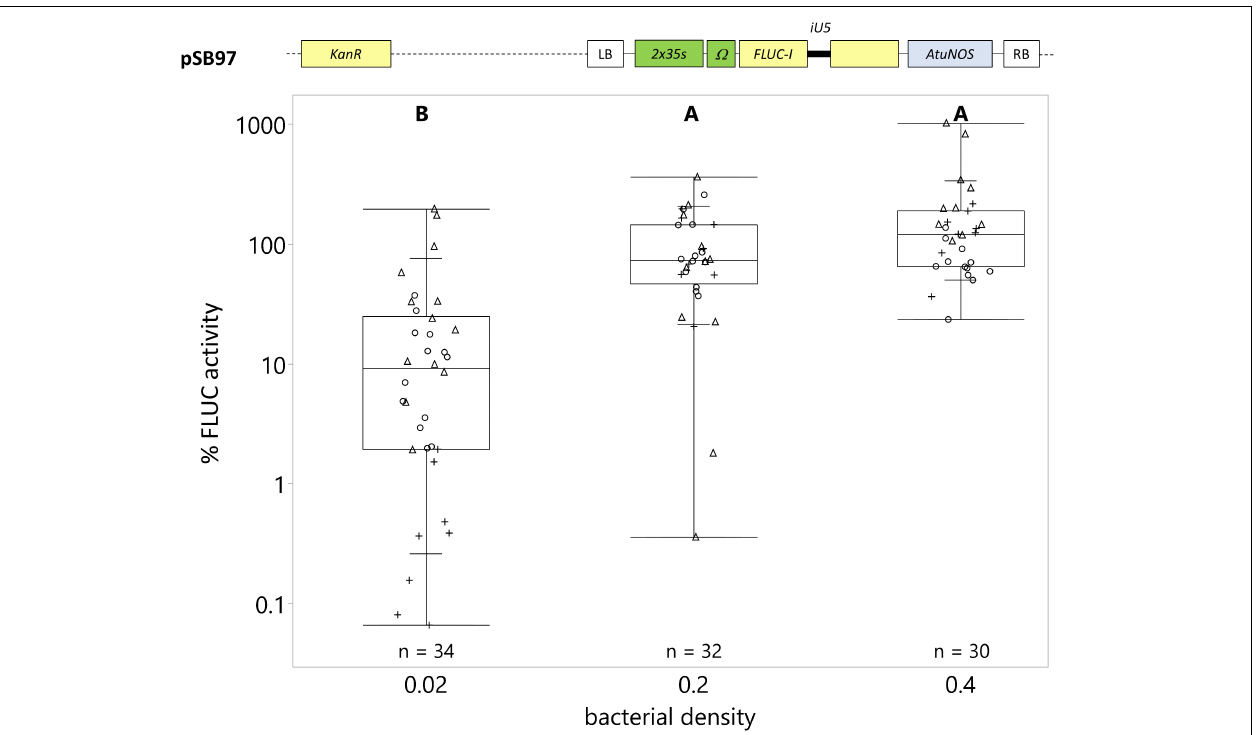
FIGURE 2 | Transgene expression is directly correlated with bacterial density during vacuum infiltration. C. roseus seedlings (10-day-old) were vacuum infiltrated with A. tumefaciens containing the FLUC-I reporter (plasmid pSB97) at OD 600 = 0.02, 0.2, and 0.4. Samples were taken at 3 dpi. FLUC activity was normalized to protein content. The average FLUC activity to protein content of seedlings infected at OD 600 = 0.2 was used as reference (set to 100%) to determine the relative FLUC activity of each sample. The experiment was carried out in three independent assays (represented by the + , (cid:13) , (cid:49) symbols). The box plot horizontal line shows the median, ends of the boxes show interquartile range, small marks show the 10th and 90th quantile and whiskers show lowest/highest data point. Different letters indicate values that are significantly different (Tukey-Kramer HSD test on log-transformed data, p < 0.05).